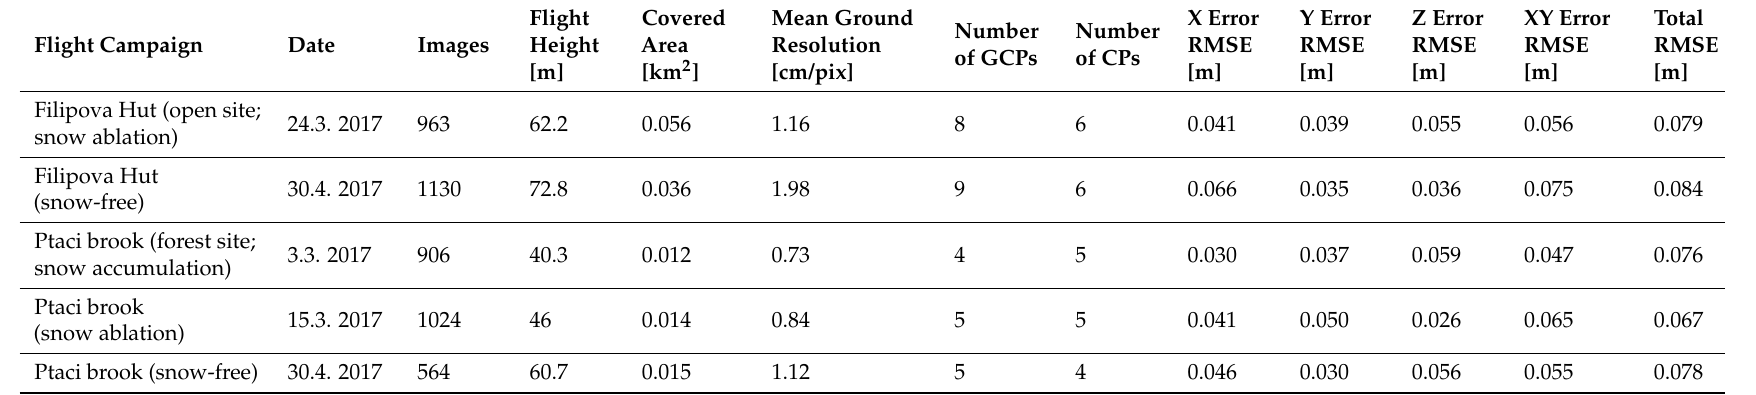
Table 3. Summary of the generated point clouds and the digital surface model (DSM) errors compared to the Global Navigation Satellite System (GNSS) elevation at ground control points (GCPs) and picked checkpoint (CP) locations of the open area and forest